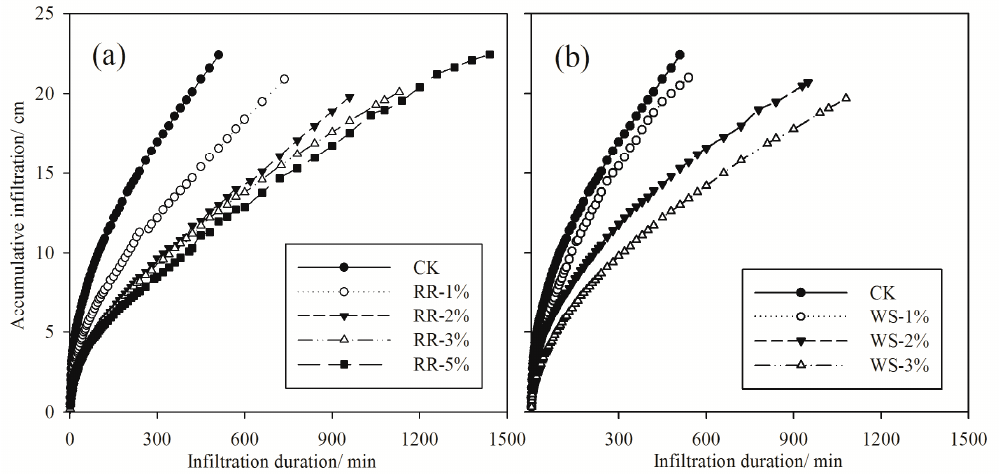
Figure 2. Relationship between accumulative infiltration and duration with various quantities of applied rapeseed-oil residue (RR) and wheat straw (WS): ( a ) Represents the treatments mixed with RR; ( b ) Represents the treatments mixed with WS.